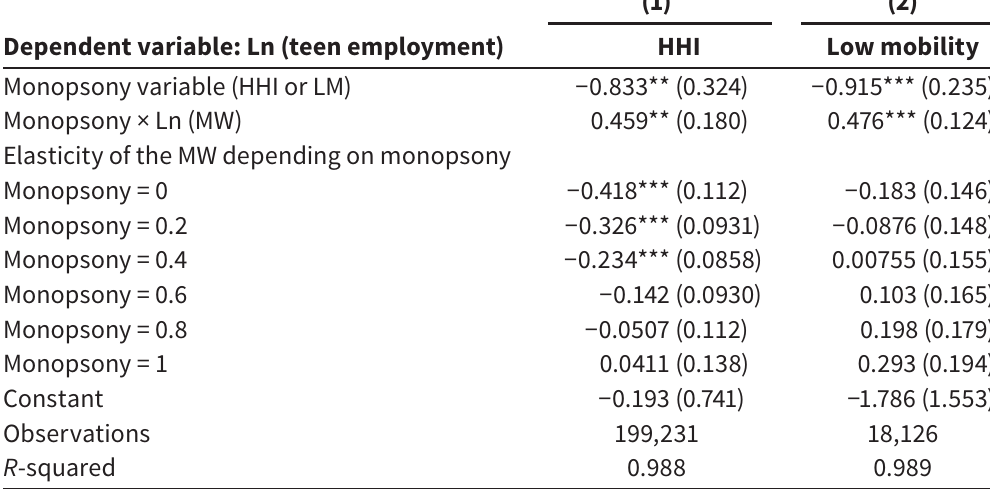
Effects of the log of the MW interacted with the HHI and low mobility on the log of teenage